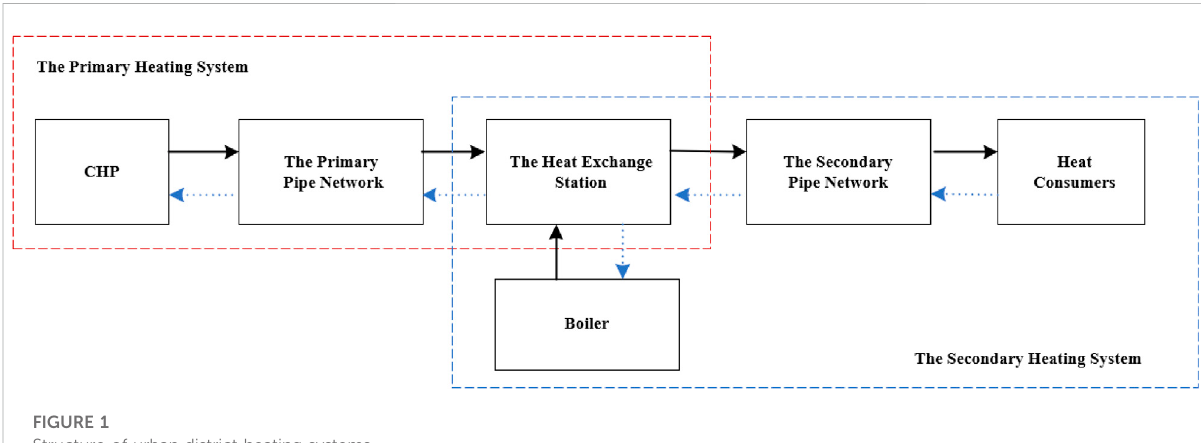
FIGURE 1 Structure of urban district heating